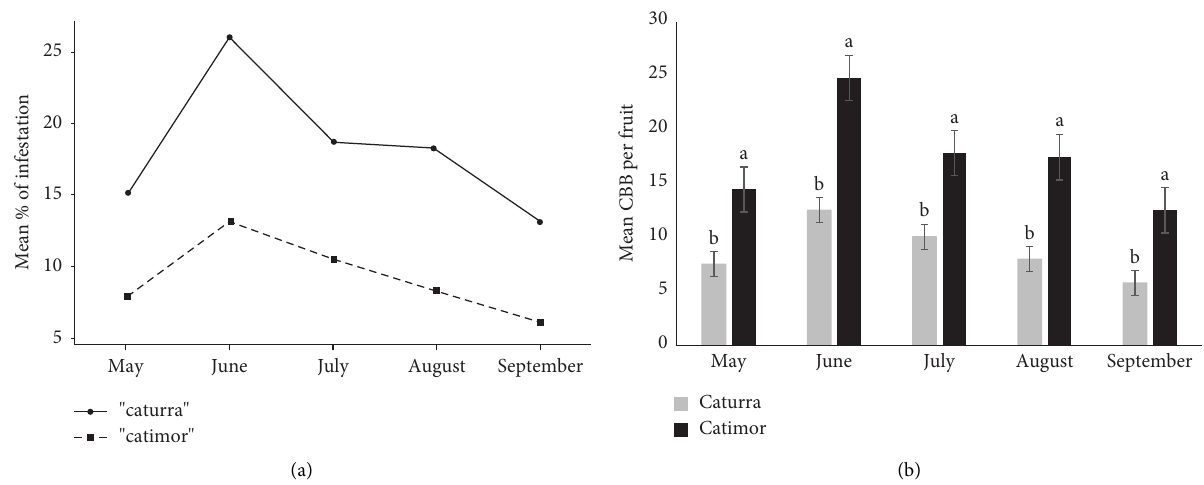
Figure 2: Monthly changes in (a) infestation and (b) CBB per fruit according to cofee variety. Letters above bars indicates statistical diferences between CBB per fruit means (means separations test are independent for each month). Table 5: GLMM estimates for CBB infestation according to the interaction between shade levels and cofee variety.